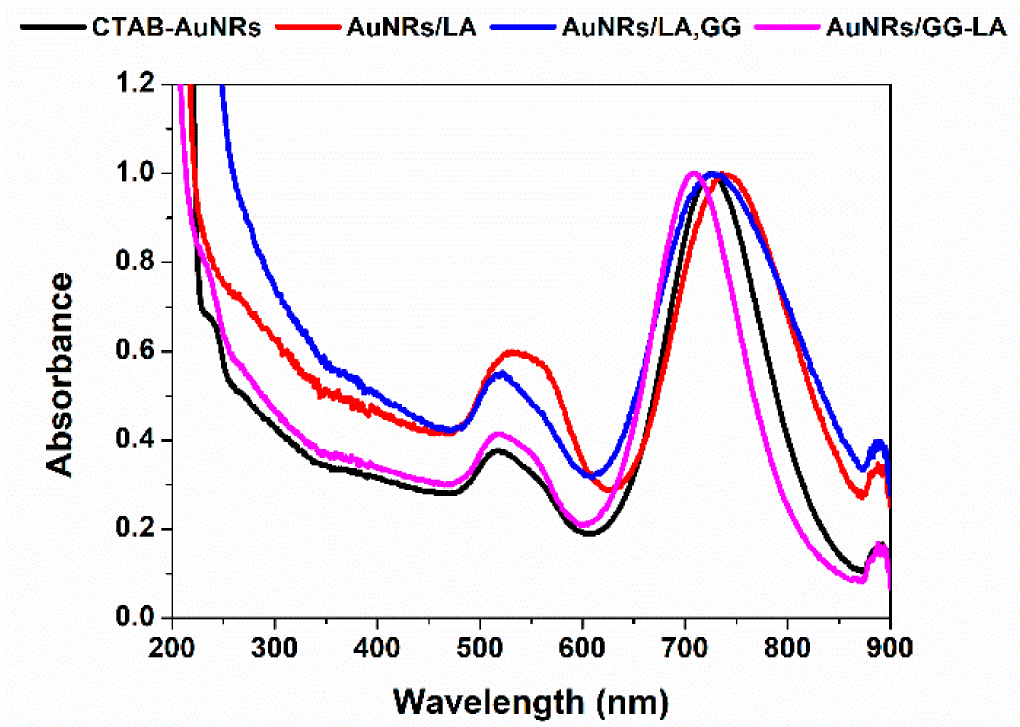
Figure 3. UV–VIS–NIR spectra of Milli-Q water dispersions of CTAB-AuNRs (black), AuNRs / LA (red), AuNRs / LA,GG (blue), and AuNRs / GG-LA (fuchsia).